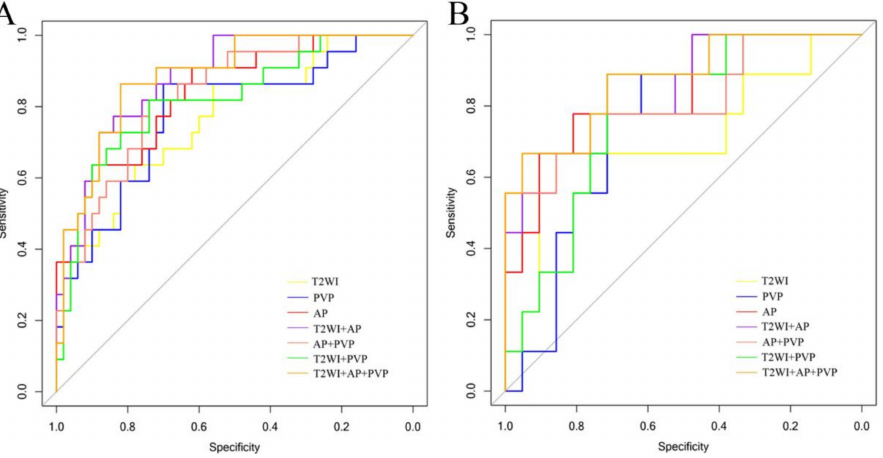
Figure 4. Comparison of the receiver operating characteristic curves of each radiomics model in the training ( A ) and validation ( B ) cohorts. Table 3. Discrimination Performance of the Different Models for LR-M